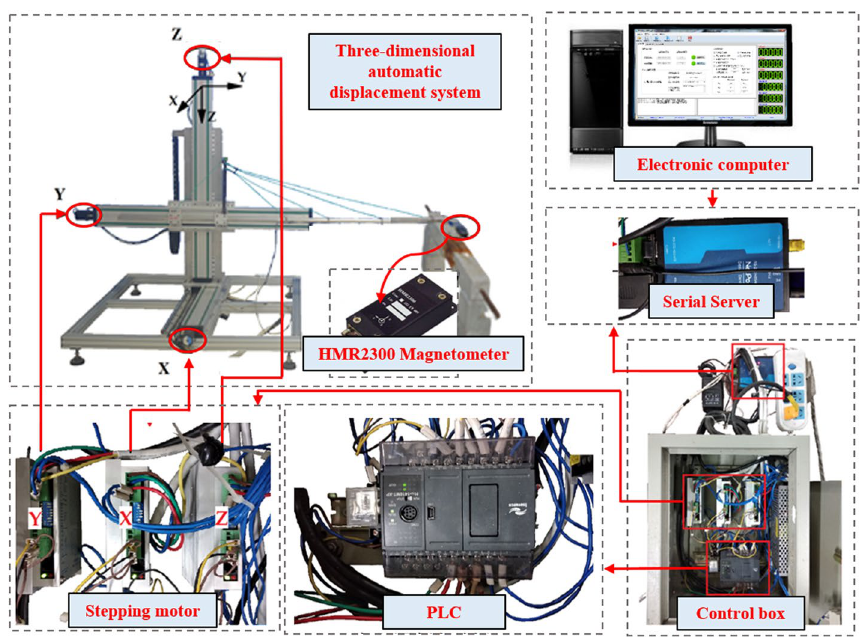
Fig. 4 Automated magnetic field scanning